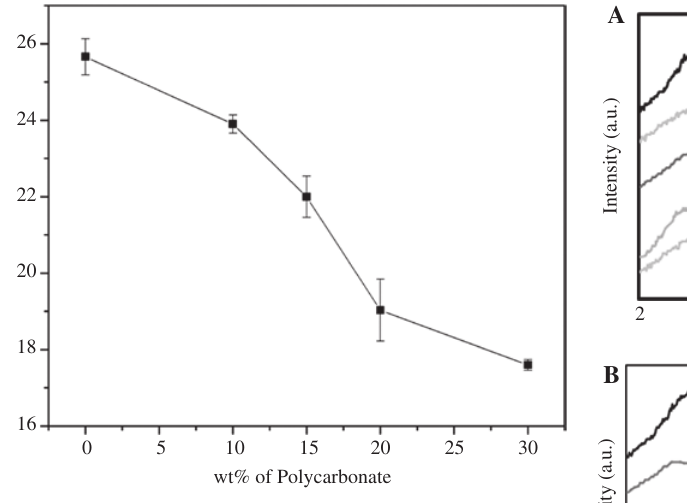
Figure 4: Effect of PC content on notched Izod impact strength of PP/PC blends.